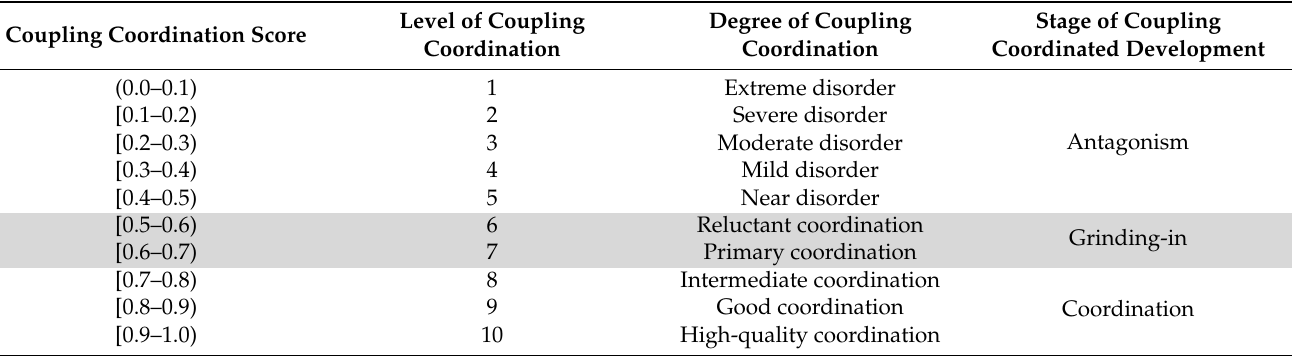
Table 2. Levels and stages of coupling coordinated development of ecological protection and high- quality